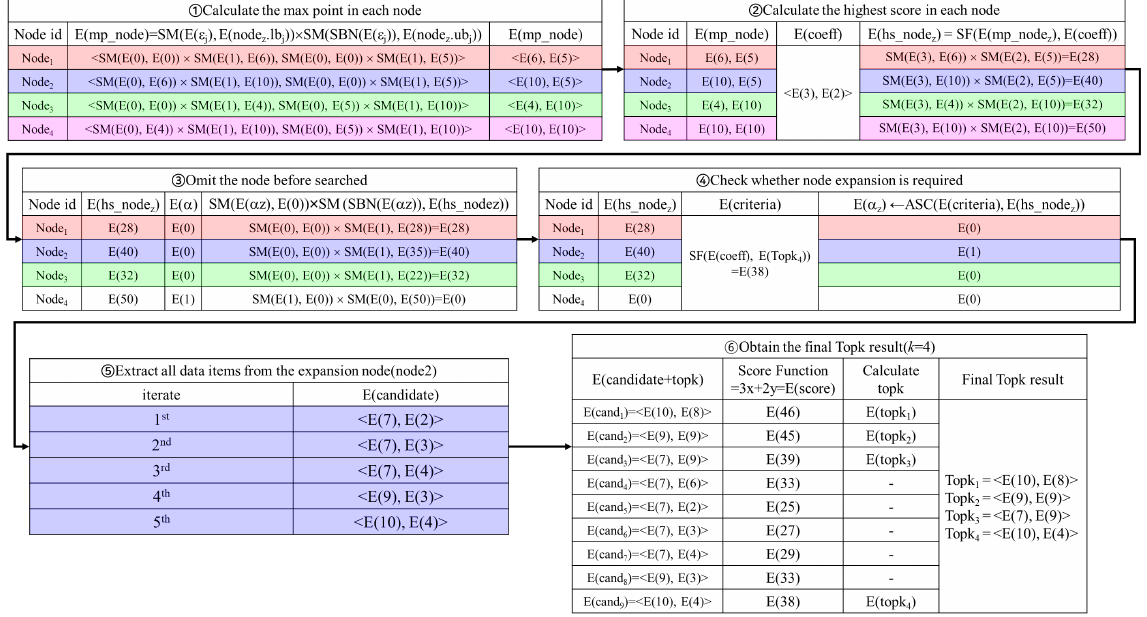
Figure 7. Example of Top- k result refinement